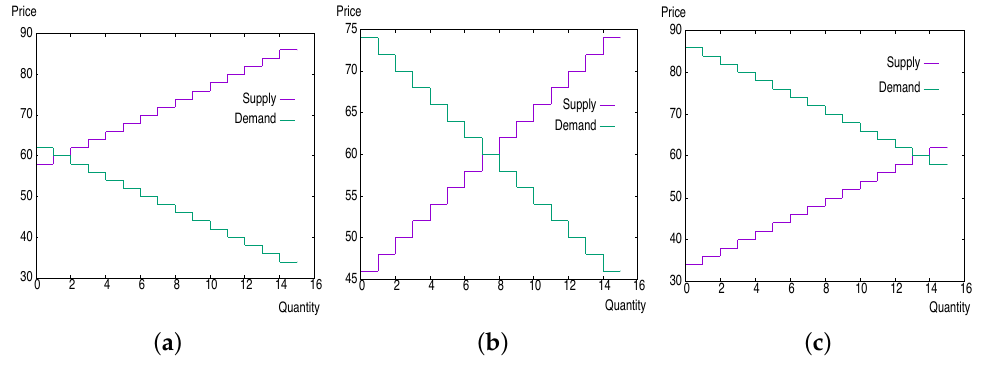
Figure 1. Market conditions. ( a ) High-risk market ( n = 1); ( b ) Medium-risk market ( n = 4); ( c ) Low-risk market ( n =